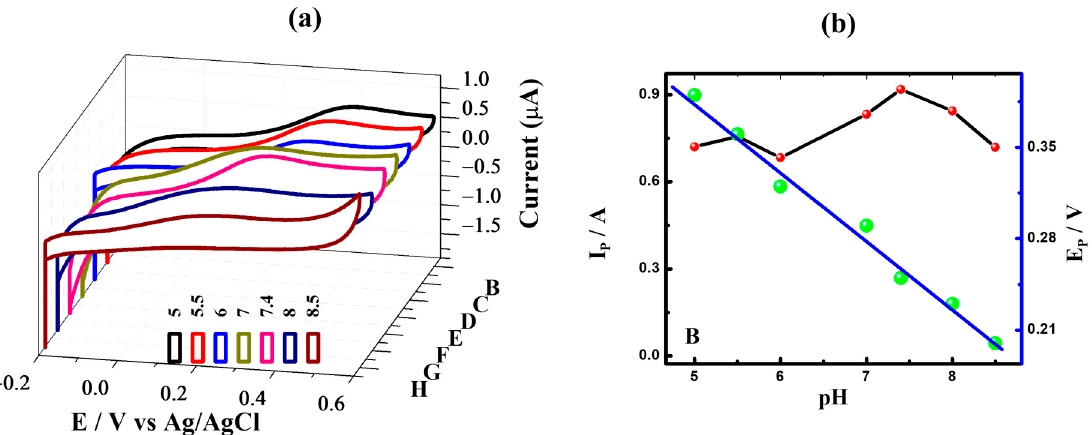
Figure 4. ( a ) CV behaviour of ZnO–g–Ru–C 3 N 4 electrode in the presences of 1 mM glucose in different pHs (5 (B), 5.5 (C), 6, (D), 7 (E), 7.4 (F), 8 (G) and 8.5 (H)) solution. ( b ) pH versus peak current (left) and peak potential (right) measured from the corresponding CV behavior.